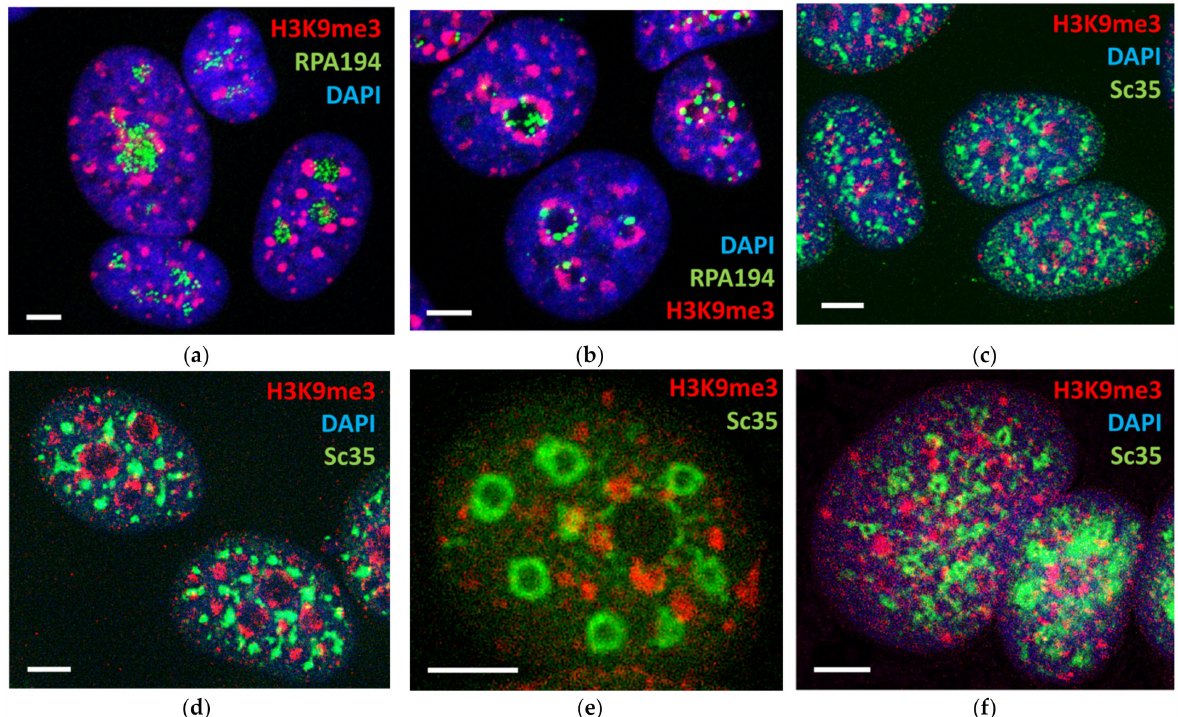
Figure 6. Partial inhibition of rRNA and mRNA synthesis by AcD and alpha-amanitin revealed the hidden radial-concentric spatial relationship between centers of nucleolar synthesis, perinucleolar PADs, and speckles; this order was destroyed after full suppression of transcription: ( a ) Control: the granules of RPA1 fill the nucleoli, indicating active rRNA synthesis; ( b ) AcD 0.2 µ M/mL, 1 h—RPA1 form rare fused granules, indicating suppressed rRNA synthesis; H3K9me3 PADs compact and encircle the nucleoli; ( c ) control: elongated speckles and PADs seem disorderly distributed in the cell nucleus; ( d ) AcD 0.2 µ M/mL, 1 h—clumped speckles surround the compacted shells of perinucleolar PADs; ( e ) alpha-amanitin 2 µ M/mL for 2 h suppressing Pol II—an example of swollen empty speckles radially circumventing the deteriorating perinucleolar ring of PADs; ( f ) AcD 2 µ M/mL for 5 h suppressing both RNA syntheses with chaotically distributed disarranged PADs and empty speckles. Scale bars = 5 µ m.